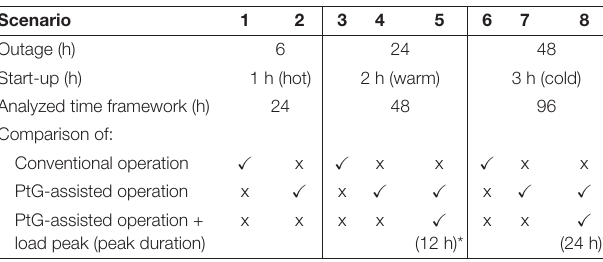
TABLE 1 | Selected scenarios for this work and types of